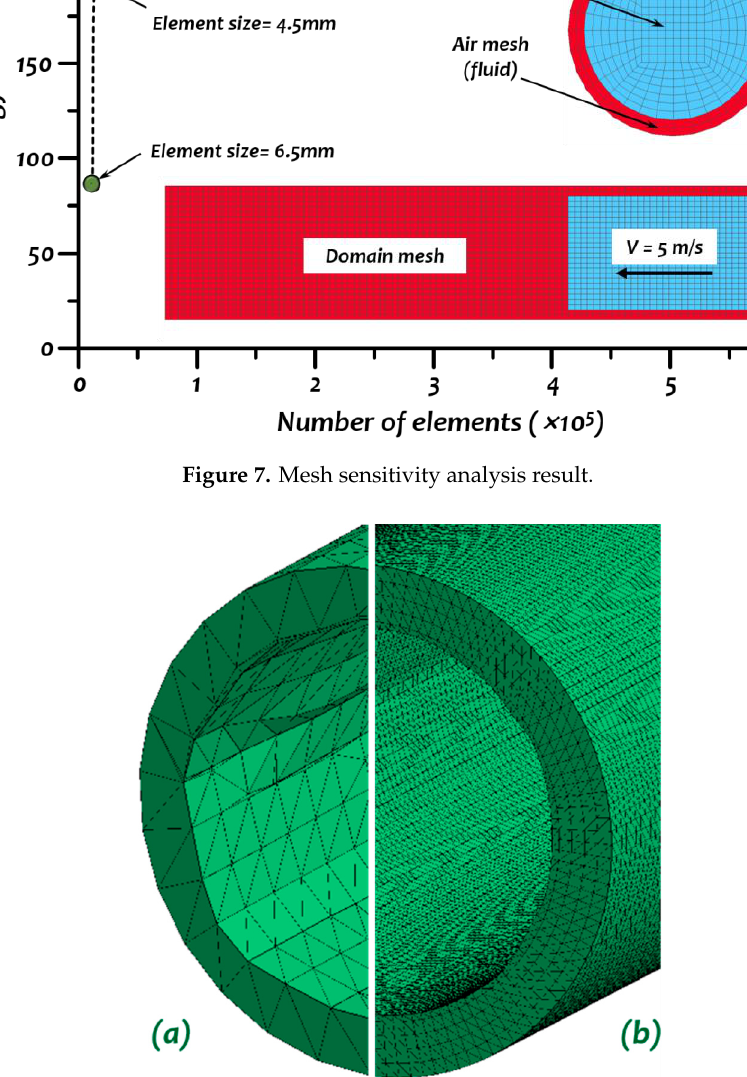
Figure 8. Fine mesh results in smoother final shape: ( a ) 4650 elements vs. ( b ) 54,612 elements.